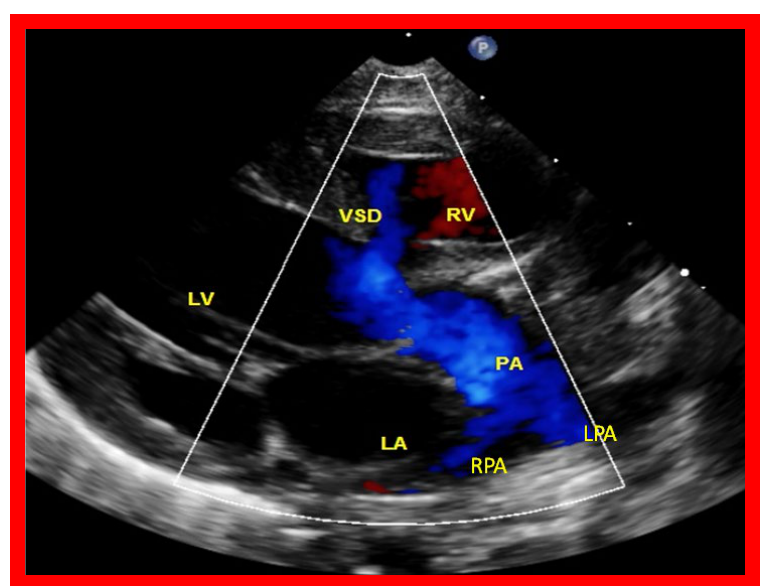
Figure 11. ( A ) A selected video frame from parasternal long axis views of a patient with tricuspid atresia and transposition of the great arteries demonstrating the left atrium (LA), left ventricle (LV), a very small right ventricle (RV) and a moderate sized ventricular septal defect (not marked). The vessel coming off the LV is traced in ( B ) and shown to bifurcate into the left (LPA) and right (RPA) pulmonary arteries, confirming that this vessel is the main pulmonary artery (MPA), consistent with transposition of the great arteries. Ao, Aorta. Reproduced from Reference [29].